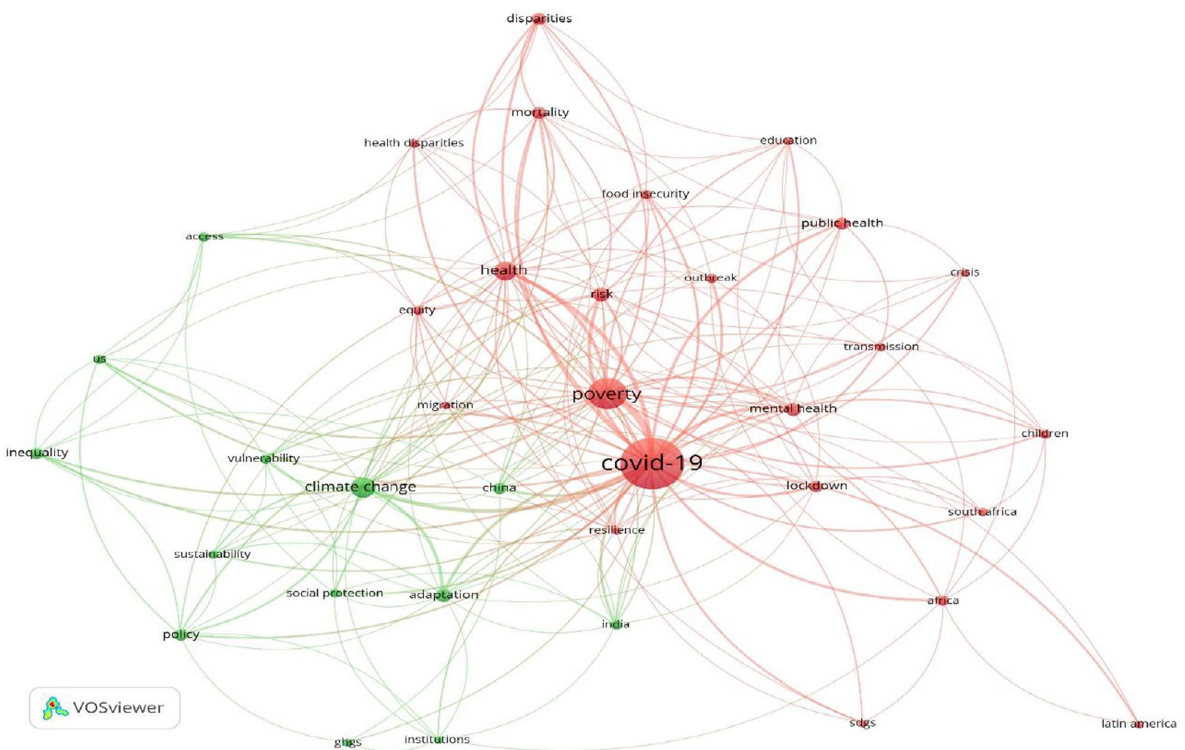
Fig. 5 Result of the term co-occurrence